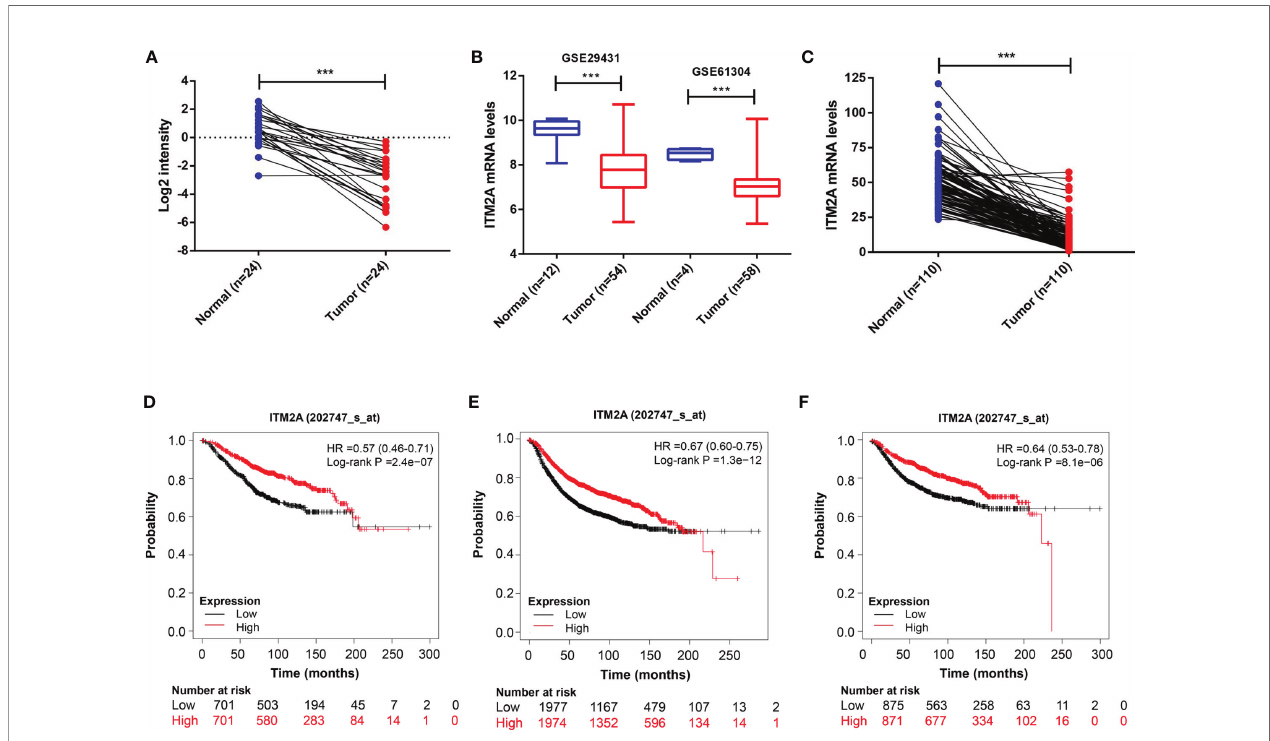
FIGURE 1 | ITM2A was down-regulated in breast cancer and positively associated with favorable outcomes. (A) Comparison of ITM2A expression in breast cancer tissues with that of paired adjacent normal tissues. (B) Boxplot showing expression level of ITM2A in cancer tissues and normal tissues in the breast pro fi le GSE29431 and GSE61304. (C) Comparison of ITM2A expression in cancer tissues with that of paired adjacent normal tissues in the breast TCGA dataset. (D-F) Kaplan-Meier survival curves depicting the OS (D) , RFS (E) , and DMFS (F) of patients with breast cancer strati fi ed by ITM2A mRNA levels. ***p < 0.001. OS, overall survival; RFS, relapse free survival; DMFS, distant metastasis free survival.